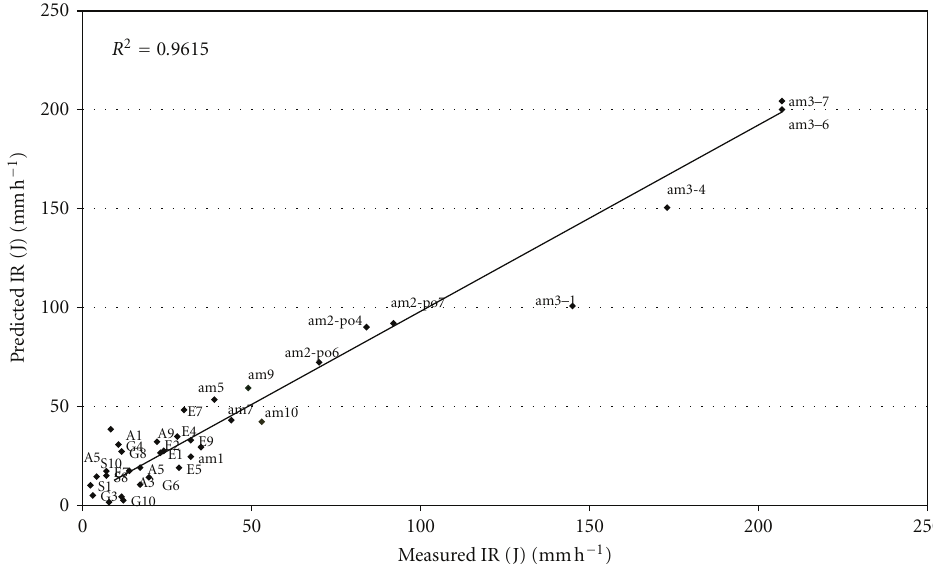
Figure 4: Measured versus predicted values of infiltration rate (IR) resulting from ANN analyses. Model run on original reflectance values, 48 wavelengths.